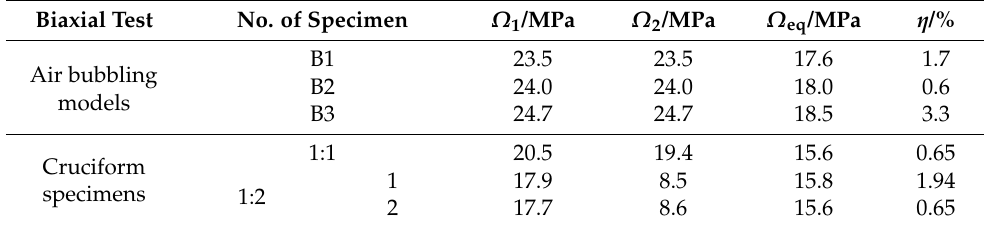
Table 7. The verification of Equation (16) using the data ( 𝛺 (cid:2869) , 𝛺 (cid:2870) , and 𝛺 (cid:2915)(cid:2927) ) . Biaxial Test No. of Specimen